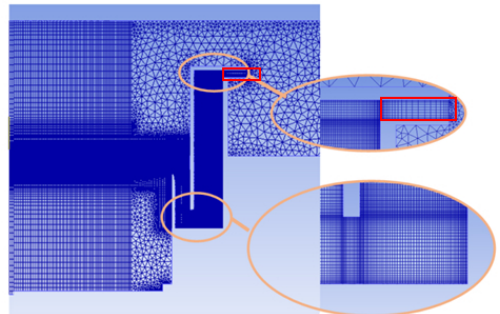
Figure 3. The spatial discretization of the computational domain. The conduit contoured by a red rectangle is modelled as a porous zone to account for the presence of the